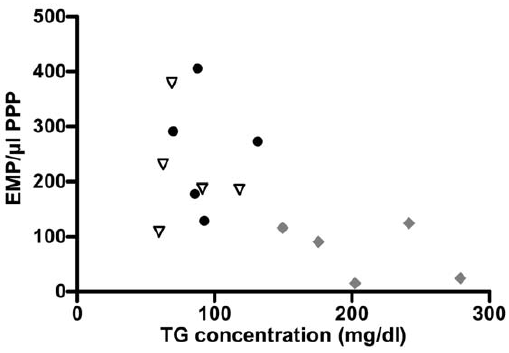
Table 2. In vivo study: results for the different study-days.